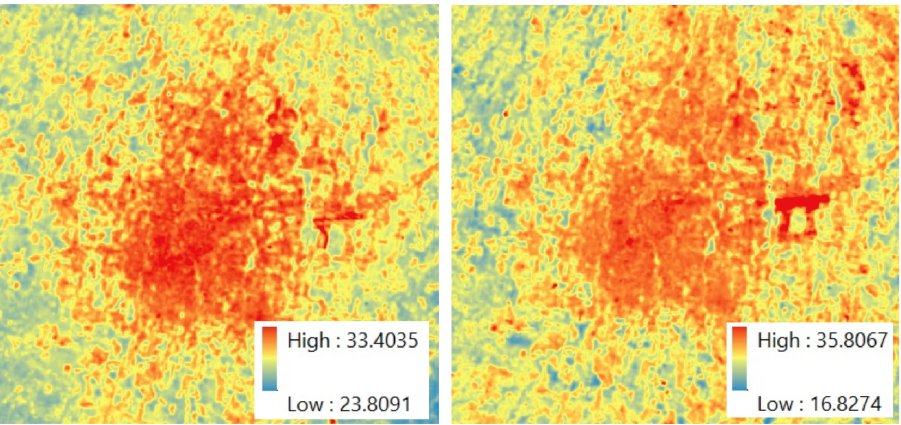
Fig. 2. LST maps of the Greater Yogyakarta Area (scale 1:130,000) retrieved from Landsat-8 OLI TIRS on May 5 at 02:47:15 (left) and August 25 at 21:50:13